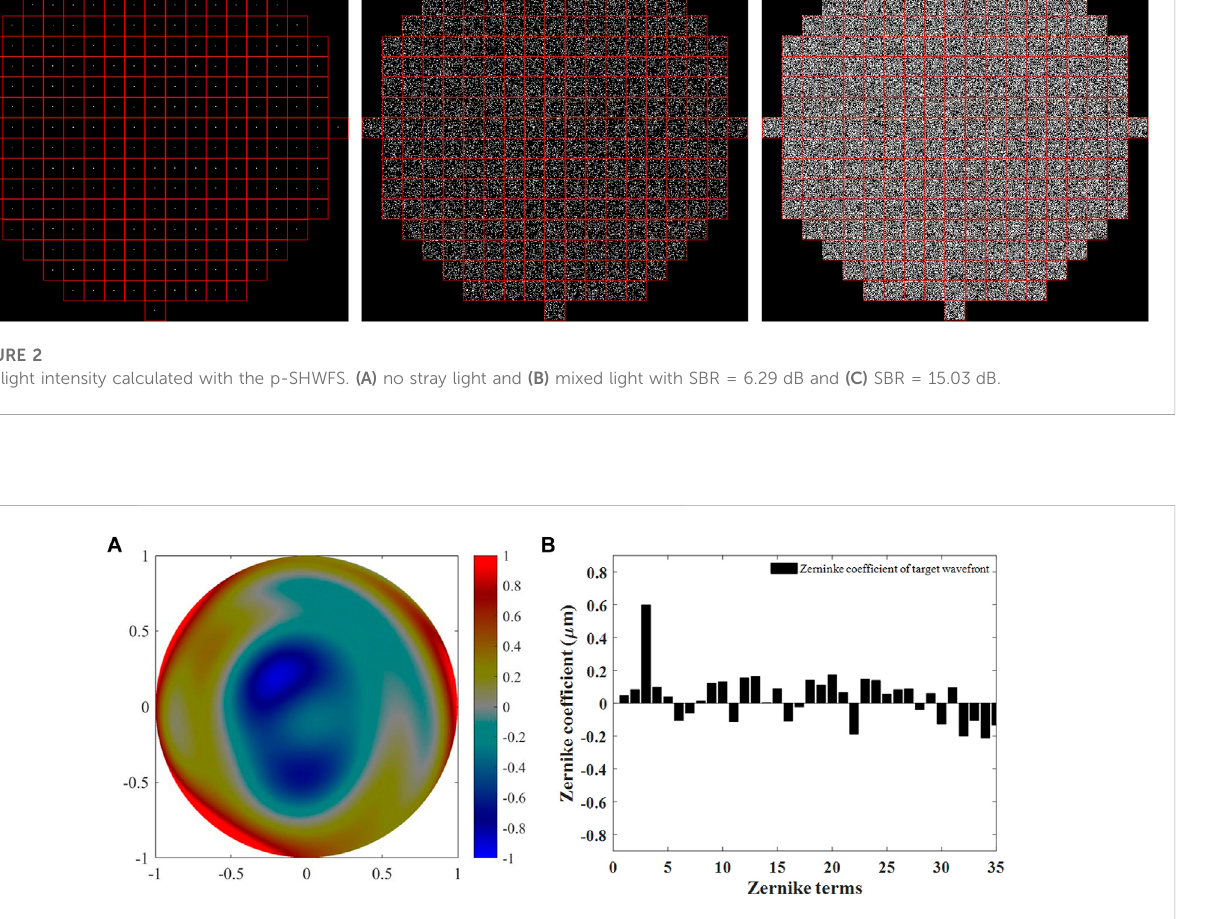
FIGURE 3 Simulated target wave (A) and its Zernike coef fi cient components (B) . All the color bar of the wavefront in this work are in units: μ